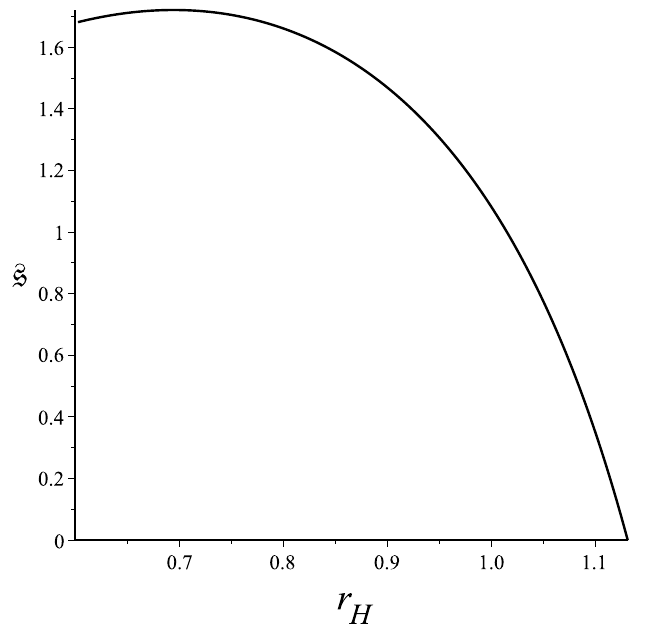
Figure 12 . The specific entropy of the black hole, with parameters as in figure 11. The domain is the one on which the black hole is stable against